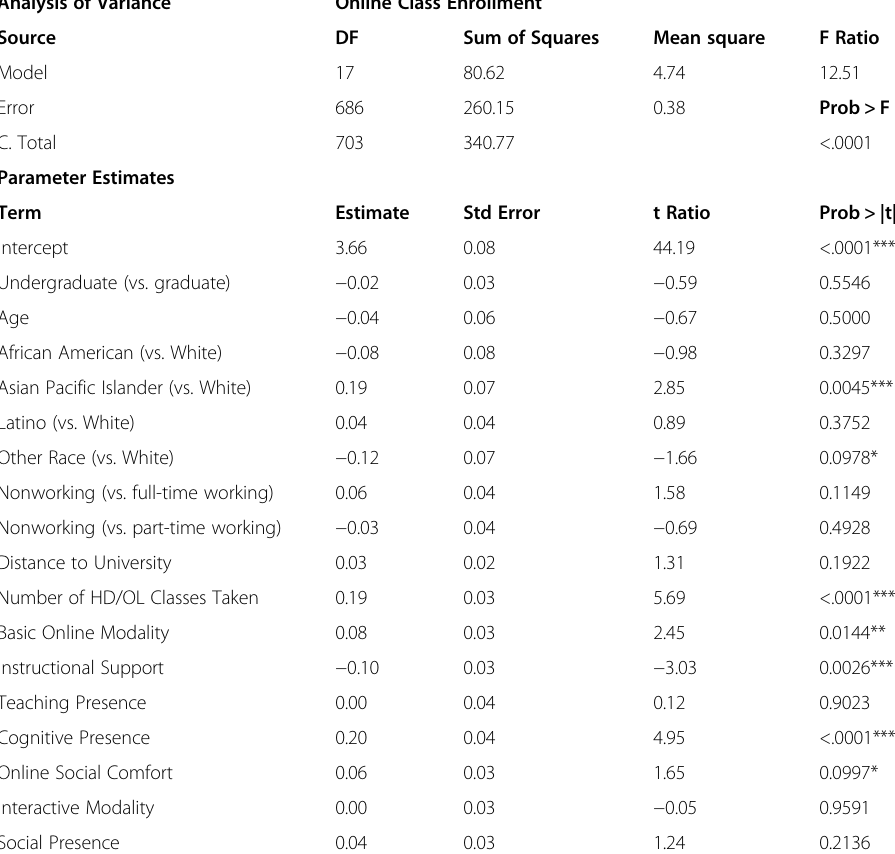
Table 6 Summary of Multiple Regression Analysis: Online Class Enrollment Analysis of